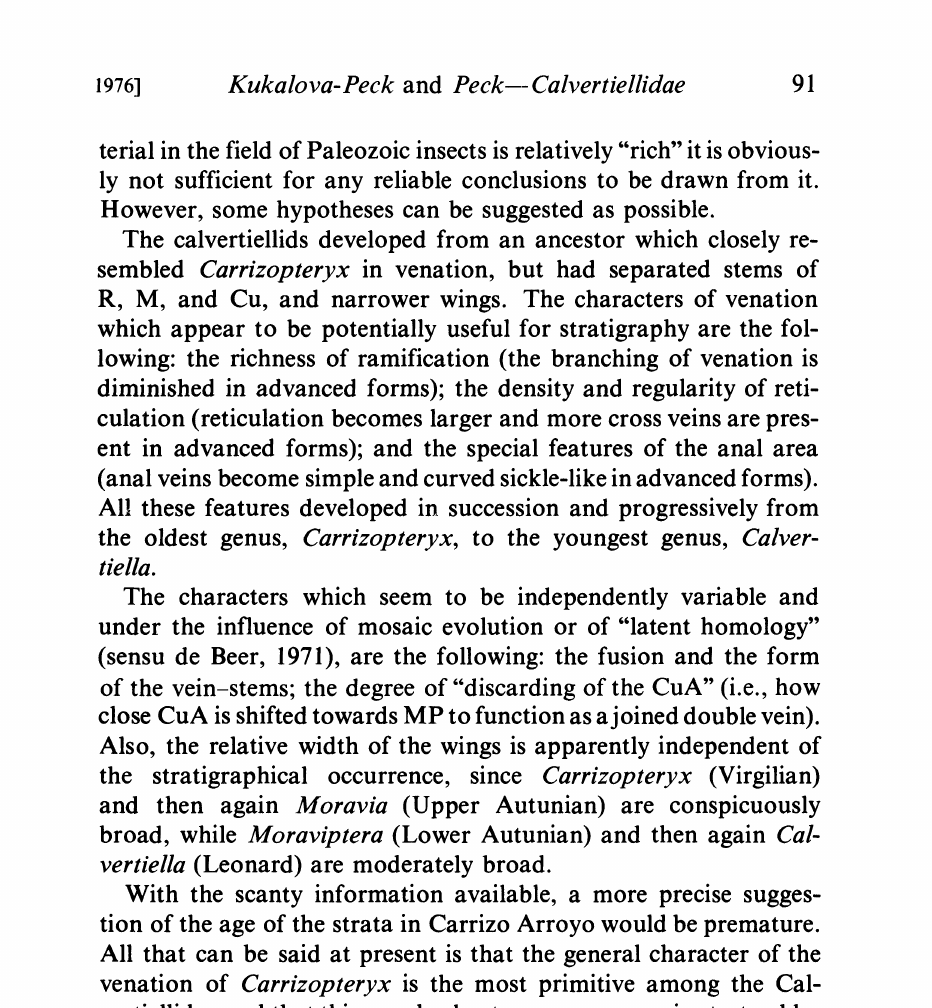
Fig. 6. Moravia convergens, young nymph; SEM photo micrograph of the wing surface with prominent tubercles. Lower Permian of Czechoslovakia. Fig. 7. Moravia convergens, subimaginal fore wing base with pteralia of palaeodictyopteroid type and the anal brace. Lower Permian of Czechoslovakia. Fig. 8. Moravia con- vergens, SEM photo micrograph. Lower Permian of